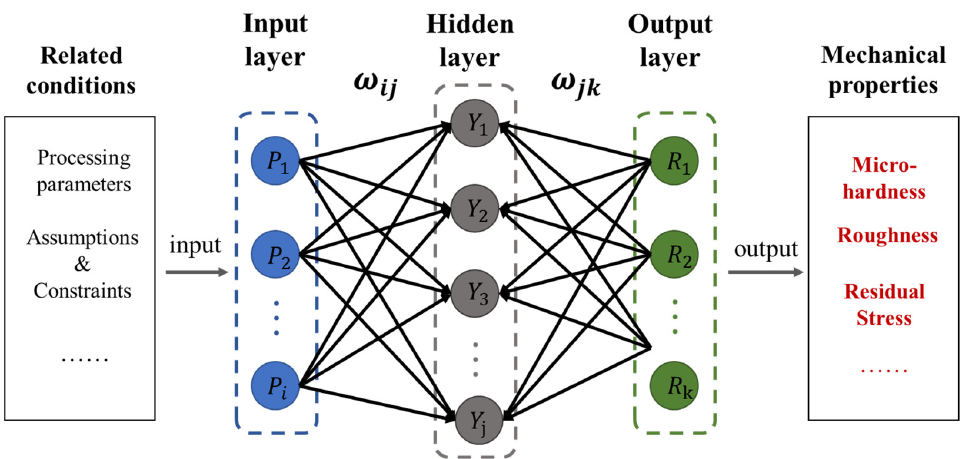
Figure 13. The structure of mechanical properties prediction model based on the artificial neural network.